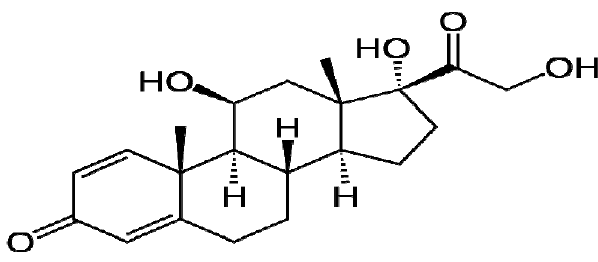
Figure 2. Chemical structure of prednisolone.